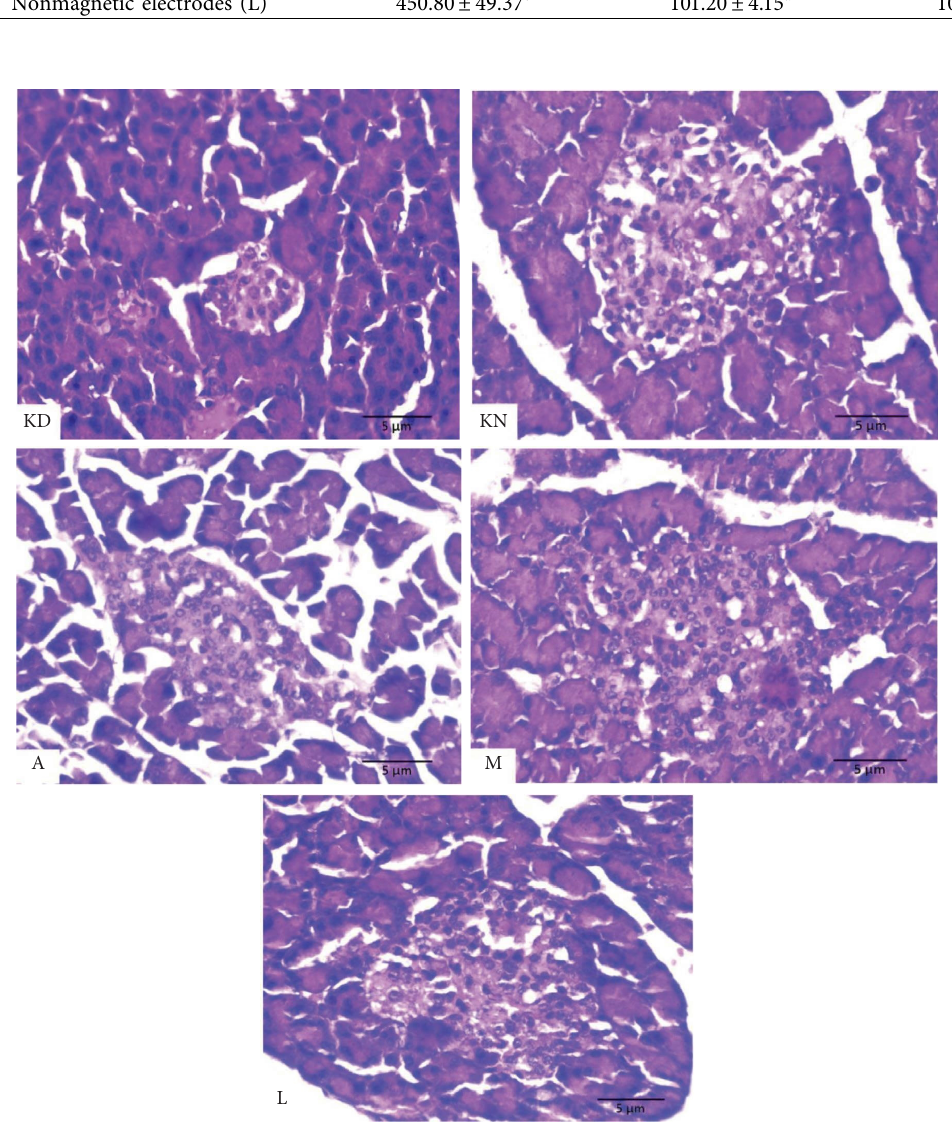
Figure 5: Comparison of the diameters of the islets of Langerhans from all treatment groups normal control (KN), diabetes control (KD), needle therapy (A), electro-stimulator therapy with magnetic electrodes (M), and electro-stimulator therapy with nonmagnetic electrodes (L). Te magnifcation of the image is